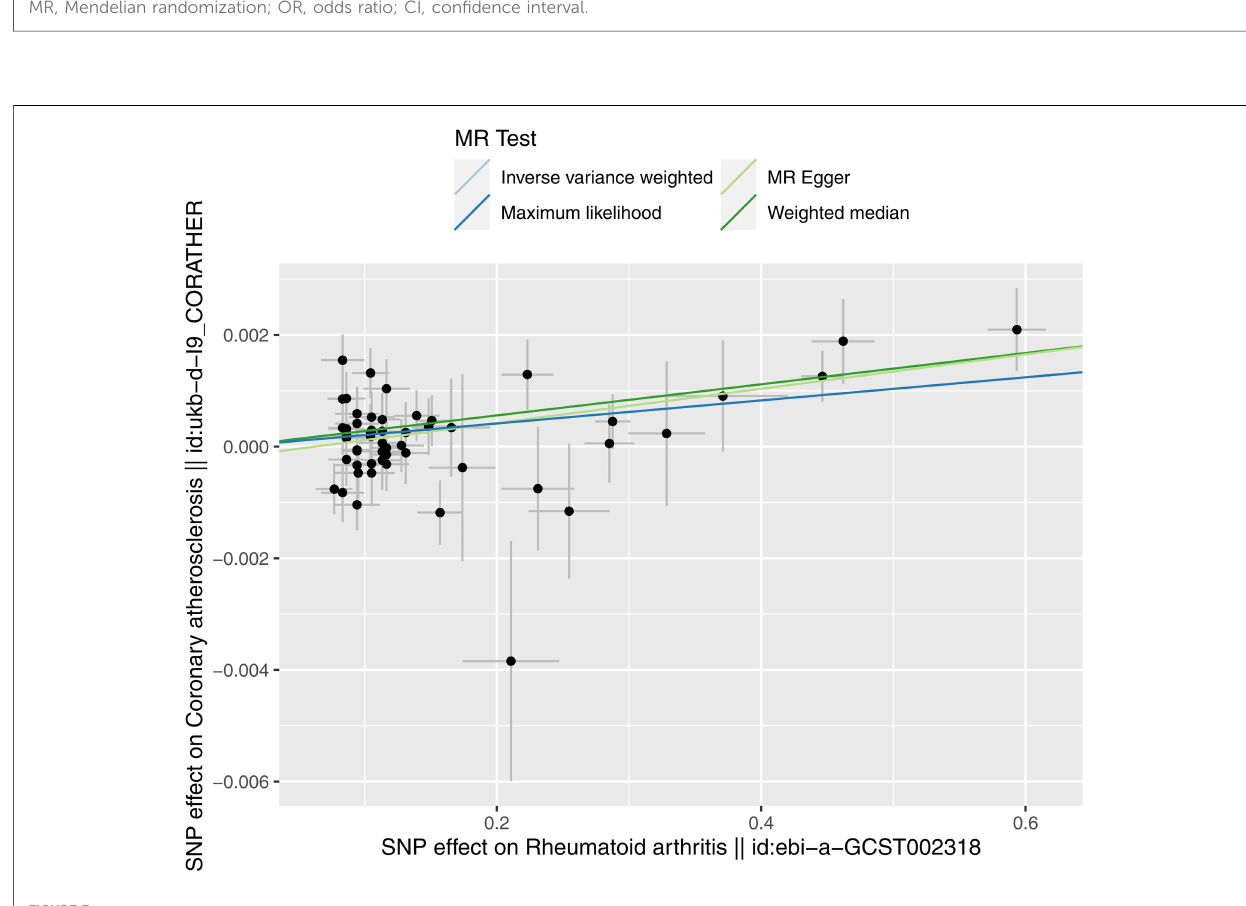
FIGURE 3 Scatter plot for RA on coronary atherosclerosis. The slope of each line corresponds to the MR effect estimated by each